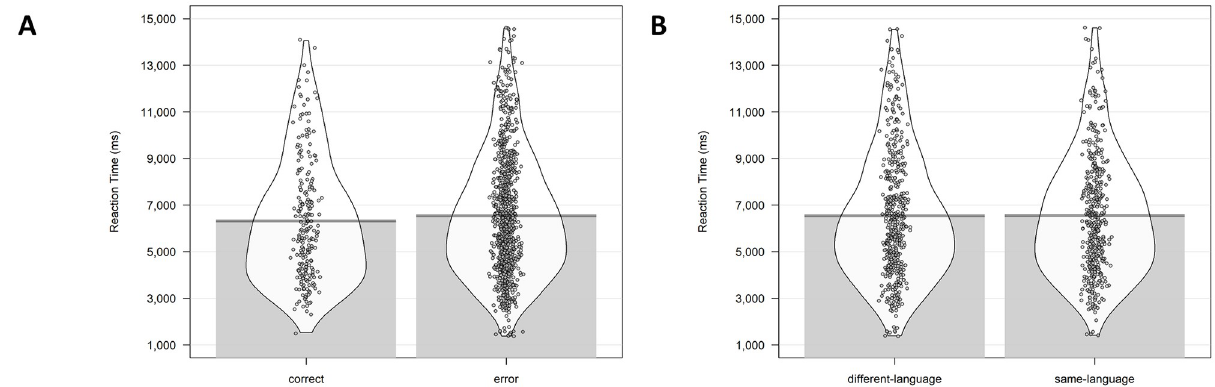
Fig 3. Analysis on Reaction Time for Study 1. (A) RT results between corrected answers and errors. (B) RT results between same-language and different-language errors. RTs in the figure are not transformed.